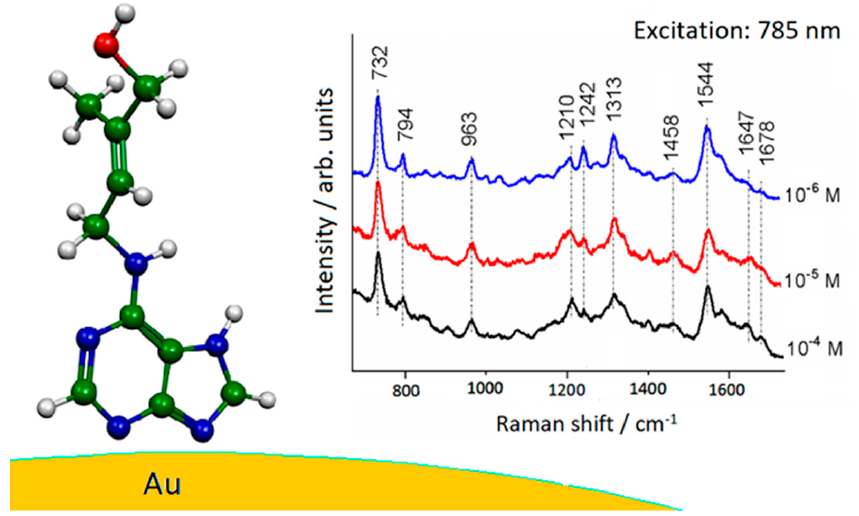
Figure 6. Adsorption of zeatin on a gold nanoparticle along with the SERS spectra obtained in Au colloid with different concentration.